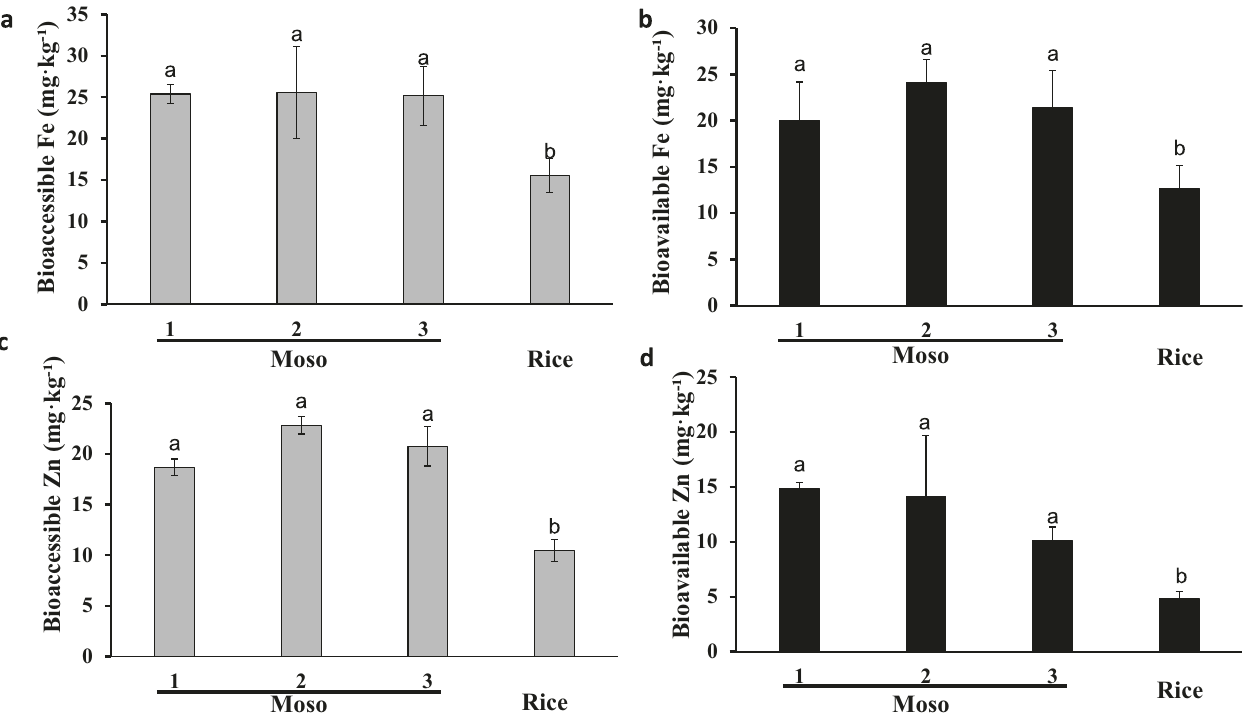
Fig. 2 Bioaccessible and bioavailable of Fe and Zn concentration in Moso bamboo seeds and rice. a Bioaccessible of Fe concentration in Moso bamboo seeds and rice. b Bioavailable of Fe concentration in Moso bamboo seeds and rice. c Bioaccessible of Zn concentration in Moso bamboo seeds and rice. d Bioavailable of Zn concentration in Moso bamboo seeds and rice. Seeds of bamboo and rice were simulated a gastrointestinal digestion in vitro, the Fe and Zn concentration in each fraction was determined by ICP-MS. Data are means ± SD ( n = 3). Statistical comparison was performed by one-way ANOVA, followed by Tukey ’ s multiple comparison test. Different lower-case letters indicate signi fi cant difference at P < 0.05.